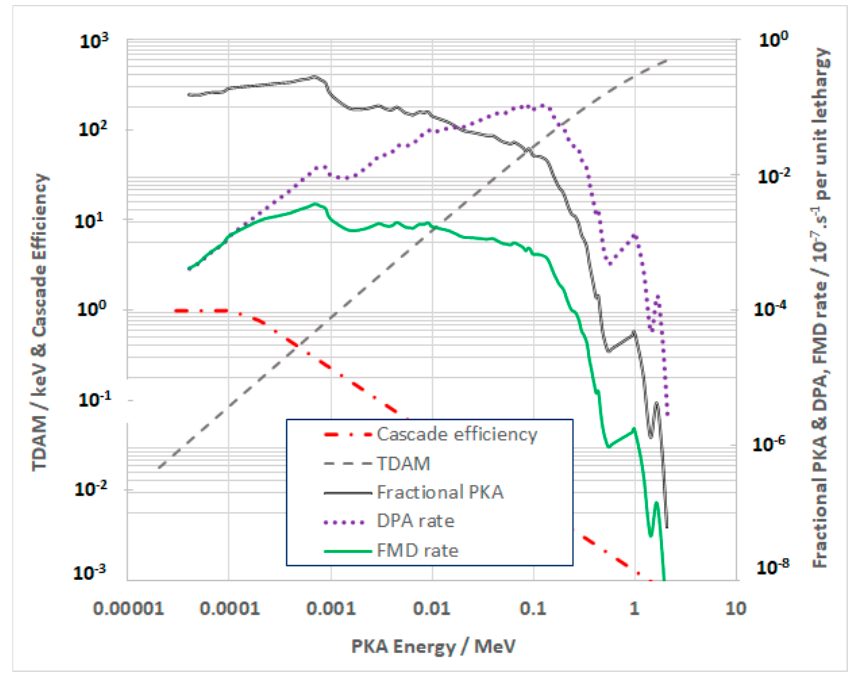
Figure 7. PKA spectrum, DPA and FMD for Ni in the CANDU reactor core as a function of cascade energies for the different PKA values.